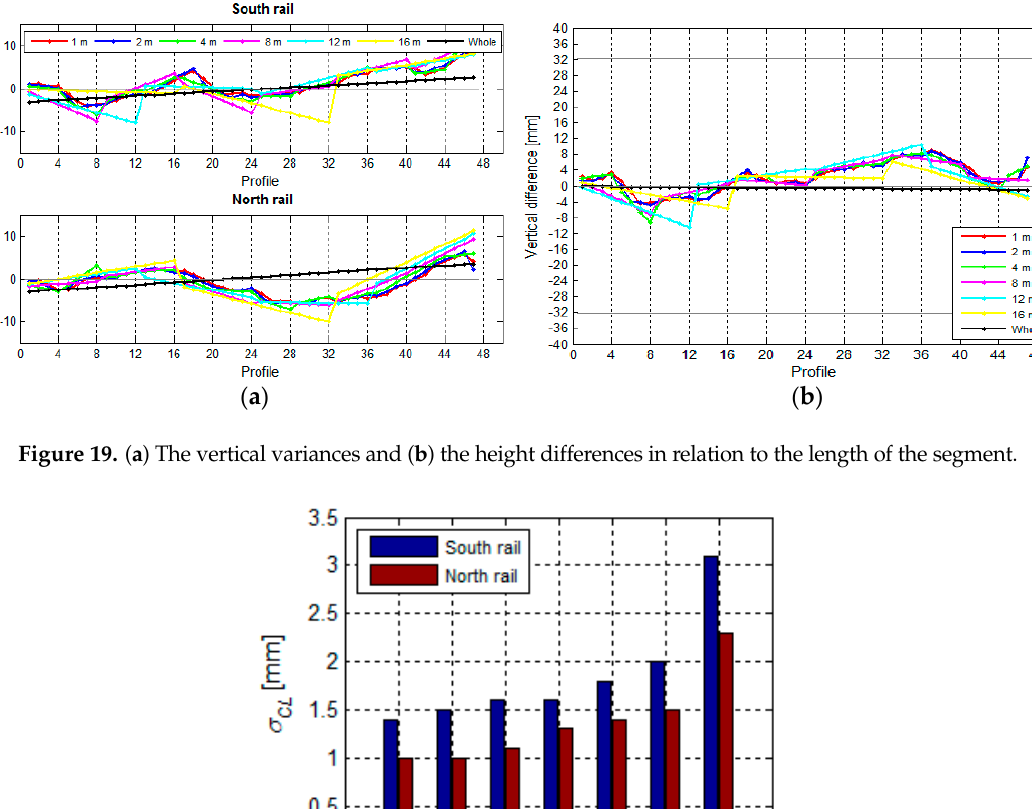
Figure 18. ( a ) The positional deviations and ( b ) the spans in relation to the segment length.